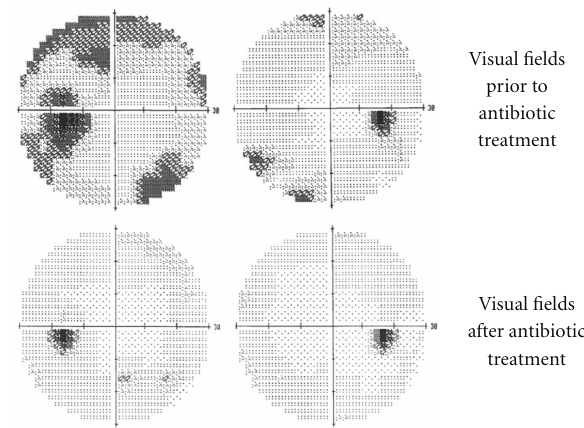
Figure 4: Visual field examination before and after treatment. Humphrey visual field testing shows improvement and resolution of enlarged blind spot after antibiotic